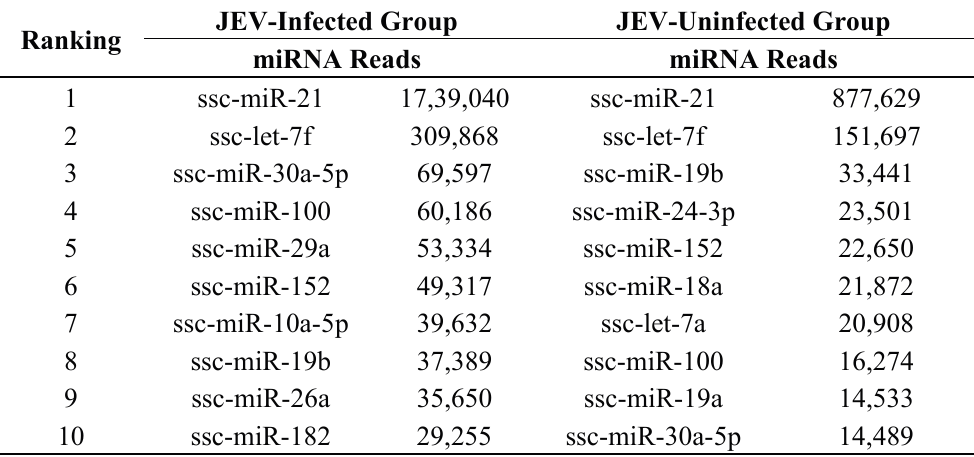
Table 1. Ten miRNAs most strongly expressed in JEV-infected and -uninfected PK-15 cells. Ranking